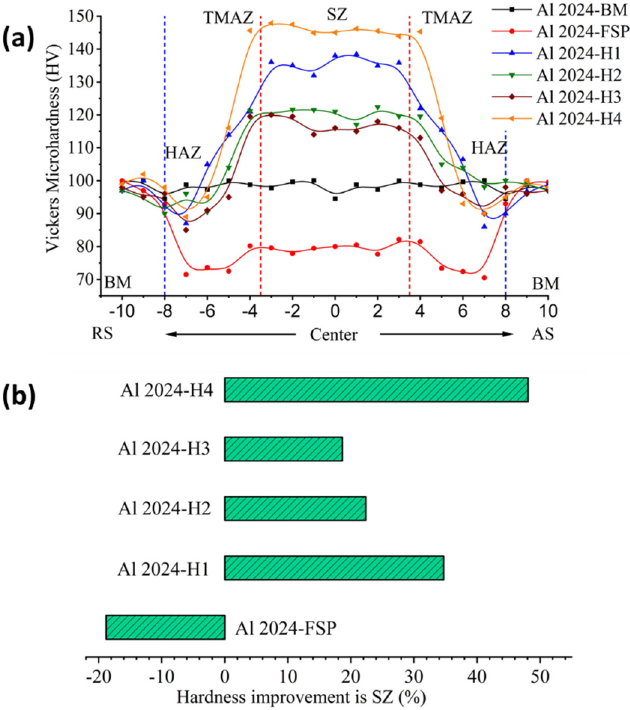
Figure 8. ( a ) Vickers micro-hardness profile of the matrix, after FSP, and manufactured surface